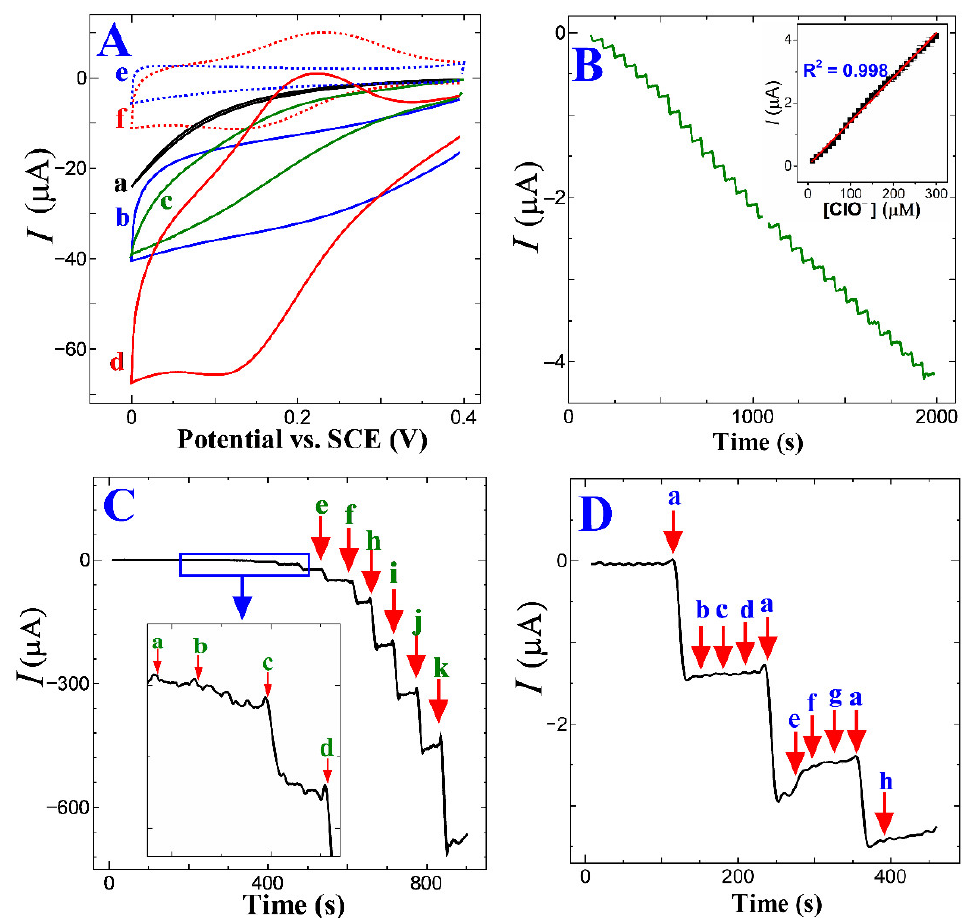
Figure 5. ( A ) CV trace on (a) bare GC, (b) ERGO, (c) p-CFA, and (d) p-CFA@ERGO/GC in 5 mM free chlorine and absence of analytes (e) ERGO/GC and (f) p-CFA@ERGO/GC at a scan rate of 50 mV s − 1 in PBS 7.2 (0.2 M); ( B ) Chronoamperometric i–t trace for every minute successive 10 µM free chlorine addition on the p-CFA@ERGO/GC and applied operating voltage at +0.17 V (inset: corresponding current vs. free chlorine concentration); ( C ) wide-range chronoamperometry free chlorine measurement from (a) 20, (b) 50, (c) 100, (d) 200, (e) 500, (f) 1000, (g) 2000, (h) 5000, (i) 7000, (j) 10000, and (k) 20000 µM, and ( D ) p-CFA@ERGO/GC selectivity test with 10 µM free chlo-